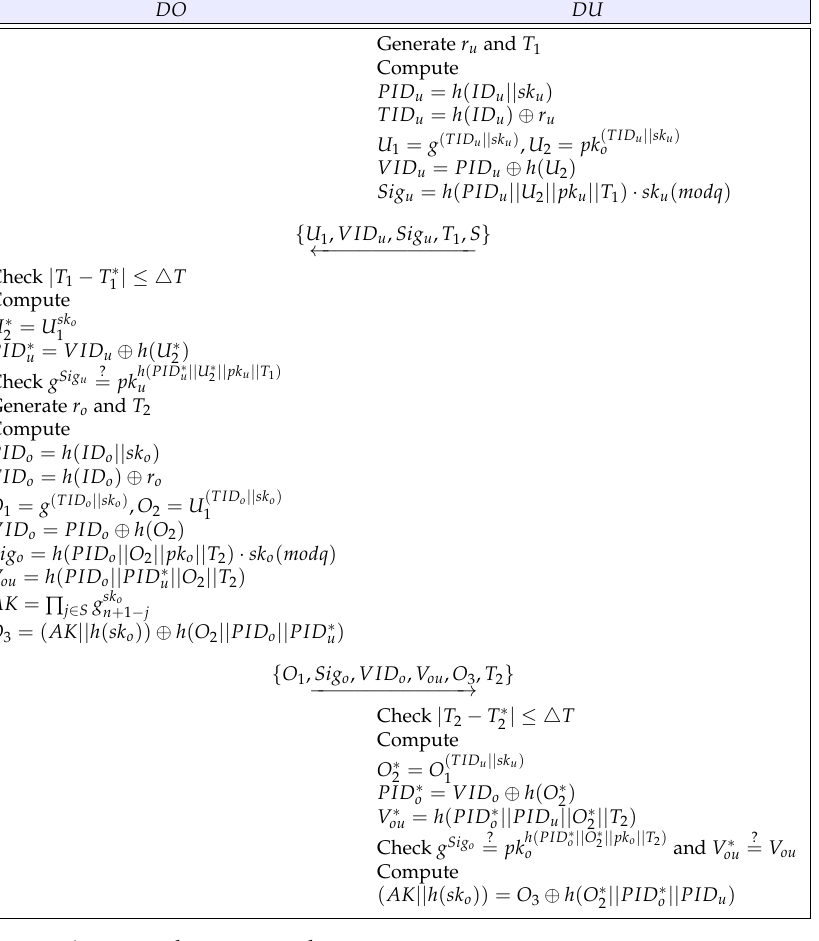
Figure 3. Aggregate key request